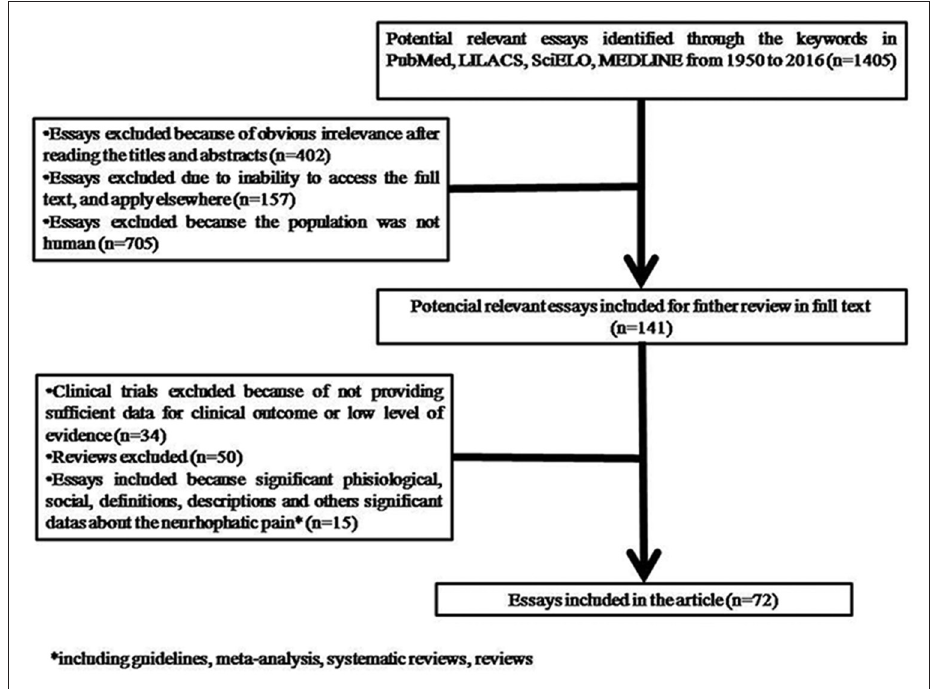
FIGURE 1. Articles were searched in several databases, using the keywords “neuropathic pain” and “spinal cord stimulation.” After apply- ing the relevance, completeness and quality criteria, 72 out of 1405 identified articles were selected.